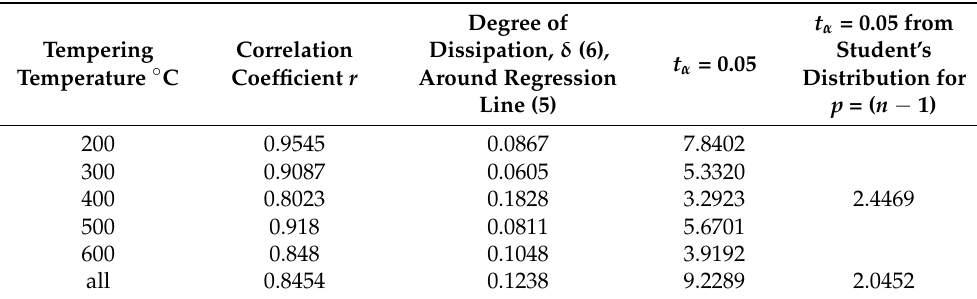
Table 2. Statistical parameters representing mathematical Equation (5), correlation coefficients, and dissipation